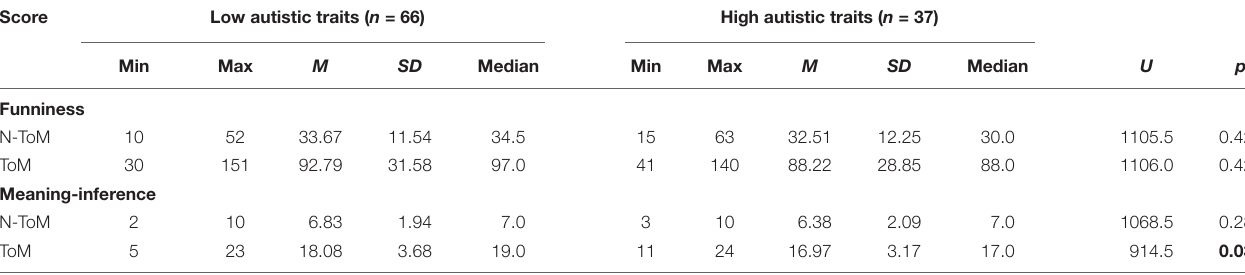
TABLE 4 | Descriptives and comparison of ToM-HCAT scores for high- and low-autistic traits groups. Score Low autistic traits ( n = 66) High autistic traits ( n = 37)